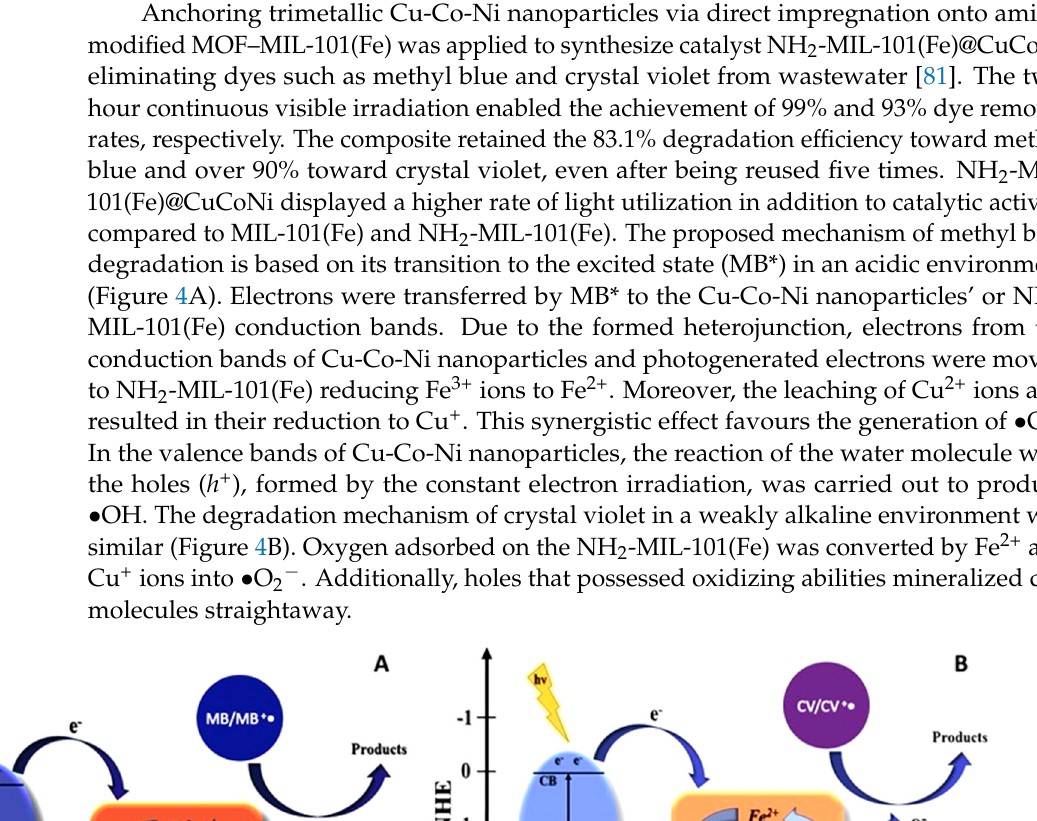
Table 1. Examples of Co-based MOFs used in the photocatalytic degradation of various dyes. Photocatalyst Dye